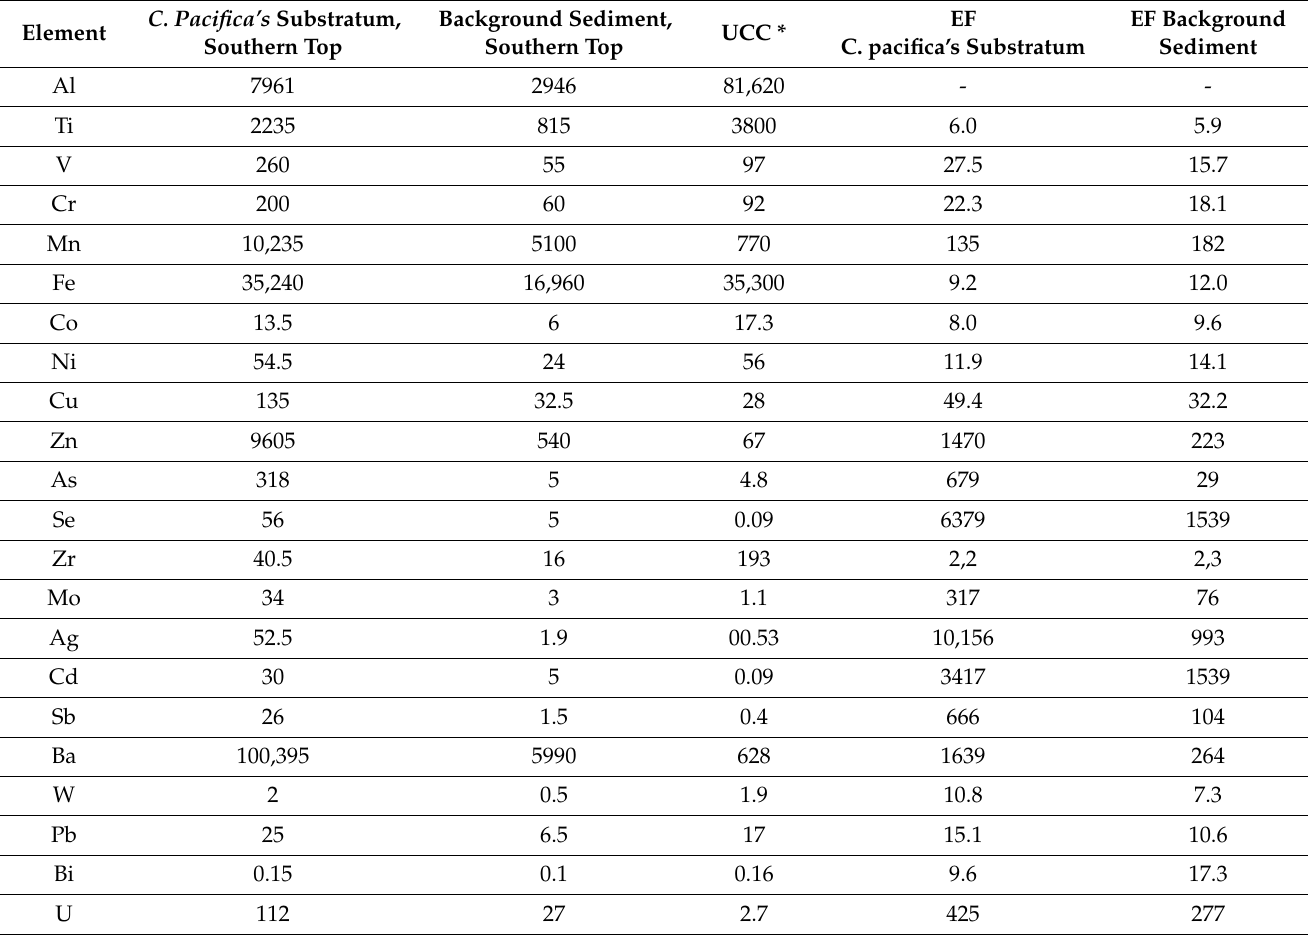
Table 4. Elemental composition (carbonate free base) of the bottom deposits at the southern tops of the Piip Volcano in comparison to the Upper Continental Crust (UCC), and the Enrichment Factor (EF)